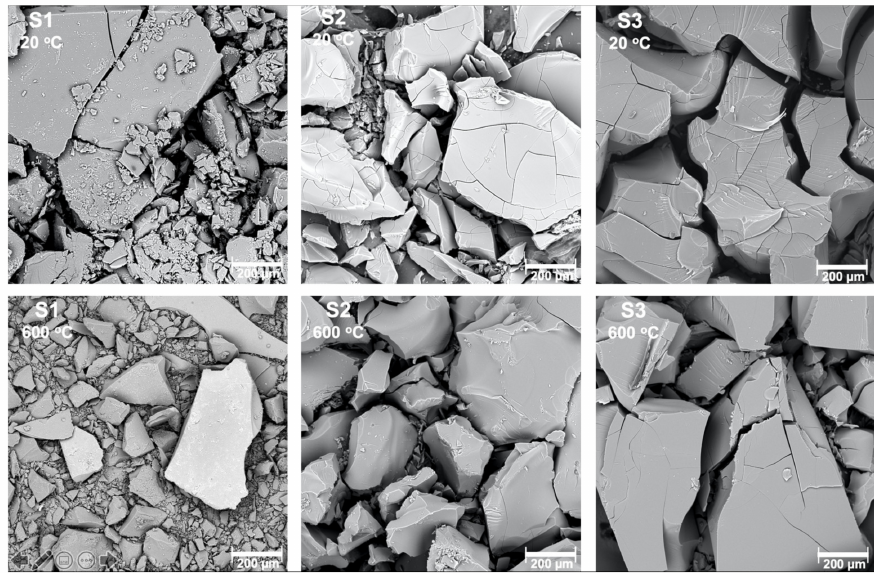
Figure 1. Scanning electron microscope pictures of the samples S1, S2, S3 before and after heat treatment in 600 ◦